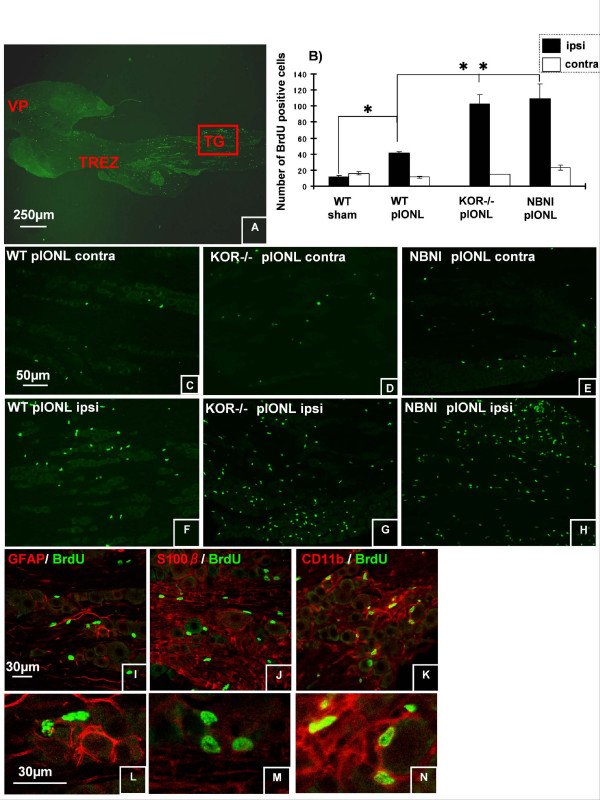
Cell proliferation in ION region in the trigeminal ganglion at day 8 after pIONL. (A) Data came from ION region in TG (the area shown in red box). (B, C, F), pIONL induced marked upregulation of BrdU positive cells in the ipsilateral side of ION region in WT mice. (B-H), in KOR-/- and norBNI pre-treated mice, the number of BrdU positive cells significantly increased compared to WT pIONL mice. (I-N) Different cellular markers (GFAP for satellite cells, S100beta for Schwann cells, CD11b for macrophage) were used to identify the phenotypes of dividing cells. Only rare cells were double labeled for BrdU and GFAP or S100beta. The majority of BrdU positive cells were CD11b positive macrophage. (*p < 0.001). Scale bars: A, 250 μm, C-H, 50 μm, I-N, 30 μm.